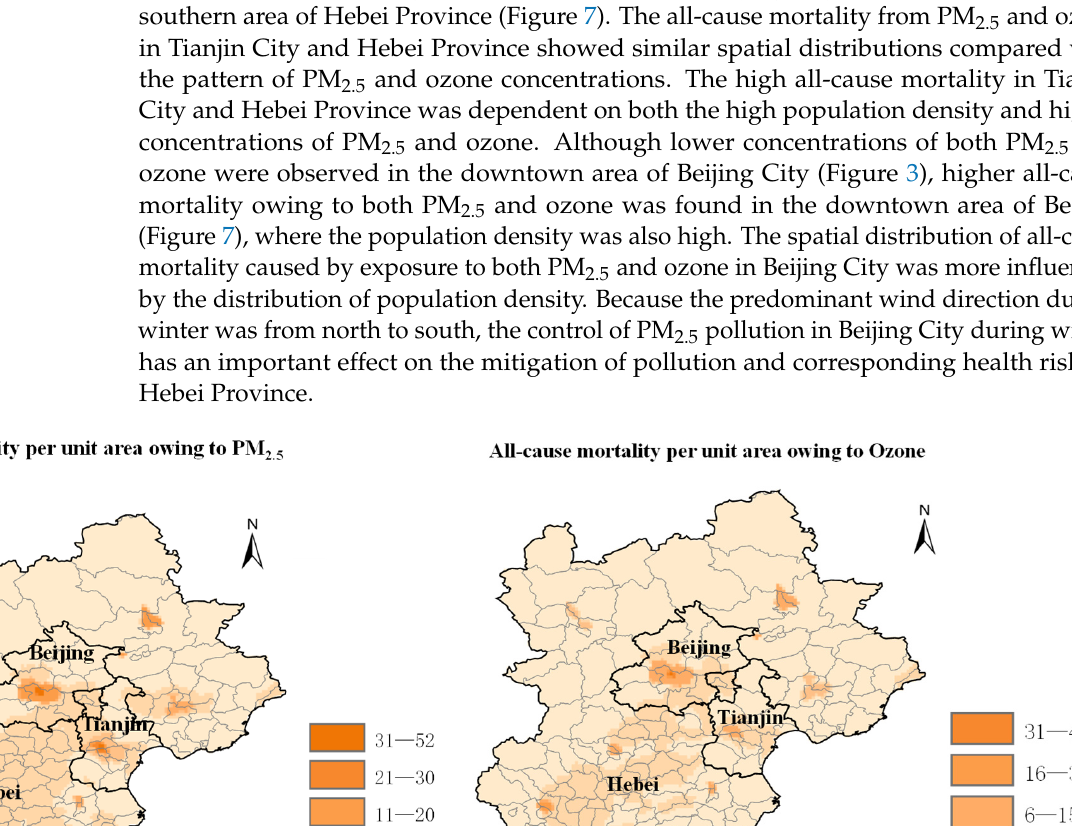
Figure 8. The annual change in mortality due to PM 2.5 (left axis) and the major compositions of PM 2.5 (right axis) in Beijing. Note: a: Ji et al., 2019 [18]. b: Want et al., 2019 [19]. c: Jia et al., 2018 [20]. d: Ding et al., 2017 [21]. e: Huang et al., 2021 [22]. f: Luo et al., 2021 [23].